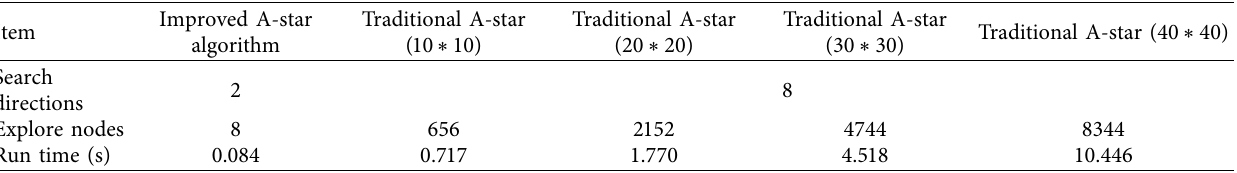
Figure 20: The results of path planning from Algiers to Rome. Table 8: Comparison of the improved A-star algorithm and traditional A-star algorithm from Madrid to Cairo.